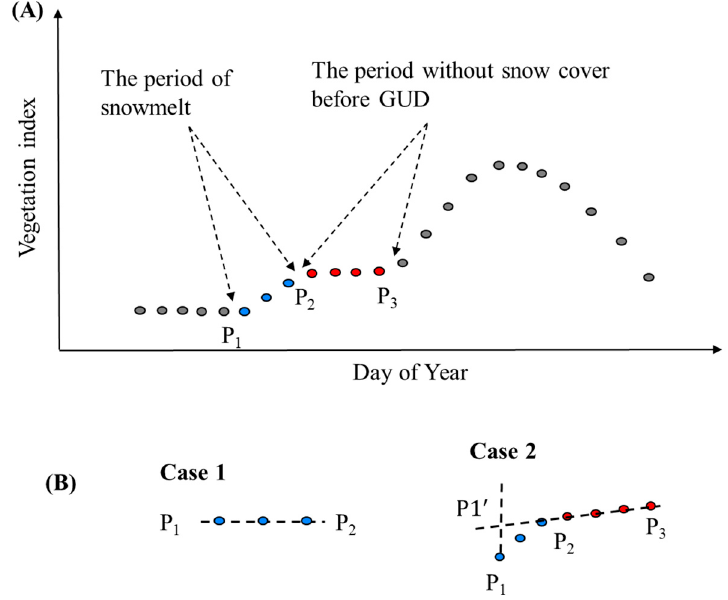
Figure 1. ( A ) A schematic showing the relationship between the background value of a vegetation index and two periods (P 1 P 2 and P 2 P 3 ); ( B ) enlarged view of the two periods. Case 1 represents the period of snowmelt and case 2 represents a period after snowmelt.